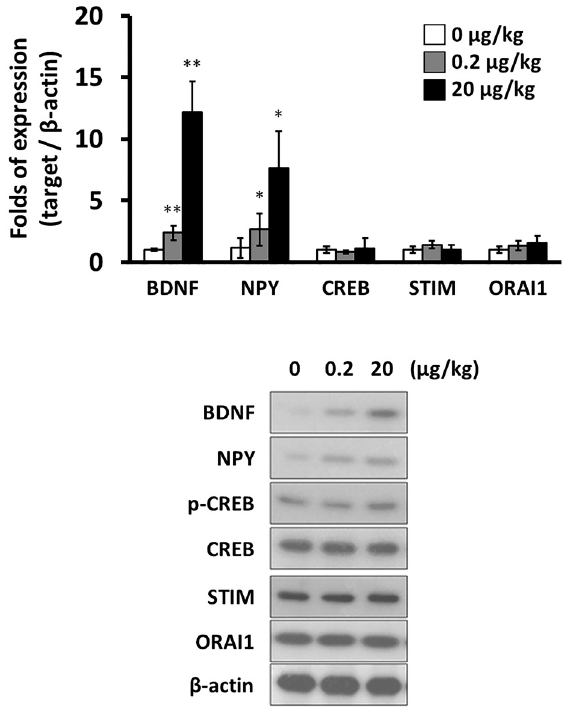
Figure 1. mRNA levels (n=3, top ) and protein levels (n=3, bottom ) of brain-derived neurotrophic factor (BDNF), neuropep- tide Y (NPY), MP-response element binding protein (CREB), stromal interaction molecule (STIM), and calcium release- activated calcium channel protein 1 (ORAI1) in scorpion venom heat-resistant peptide-treated hippocampal tissues from kainic acid-induced epileptic rats. Data are reported as means ± SD. *P o 0.05; **P o 0.01 (Mann-Whitney